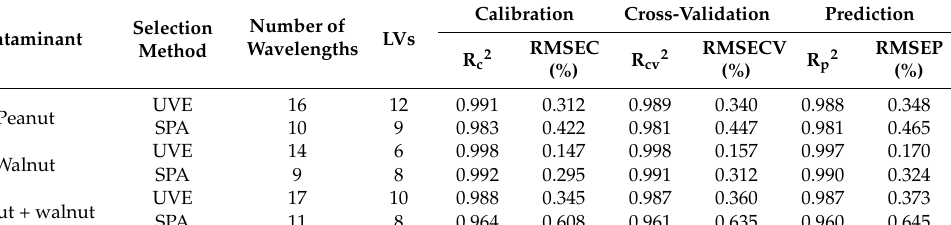
Table 2. Multispectral PLSR detection models for peanut-contaminated flour, walnut-contaminated flour and combination of them based on the corresponding selected wavelengths. RMSEC: root mean square error of calibration; RMSECV: root mean square error of cross-validation; RMSEP: root mean square error of prediction; SPA: successive projection algorithm; UVE: uninformative variable elimination.